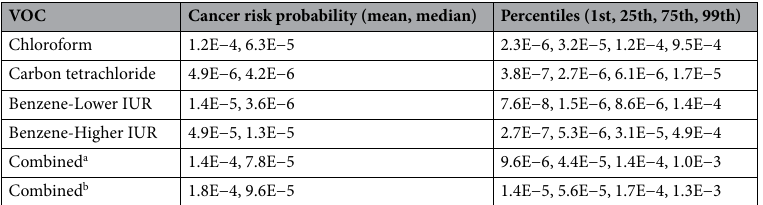
Table 7. Cancer risk probabilities for VOCs with corresponding inhalation unit risks in the integrated risk information system. Probabilities at or greater than 1 in 10,000 (≥ 1E−4) are widely viewed as excessive and unacceptable. a Using lower IUR for benzene. b Using higher IUR for